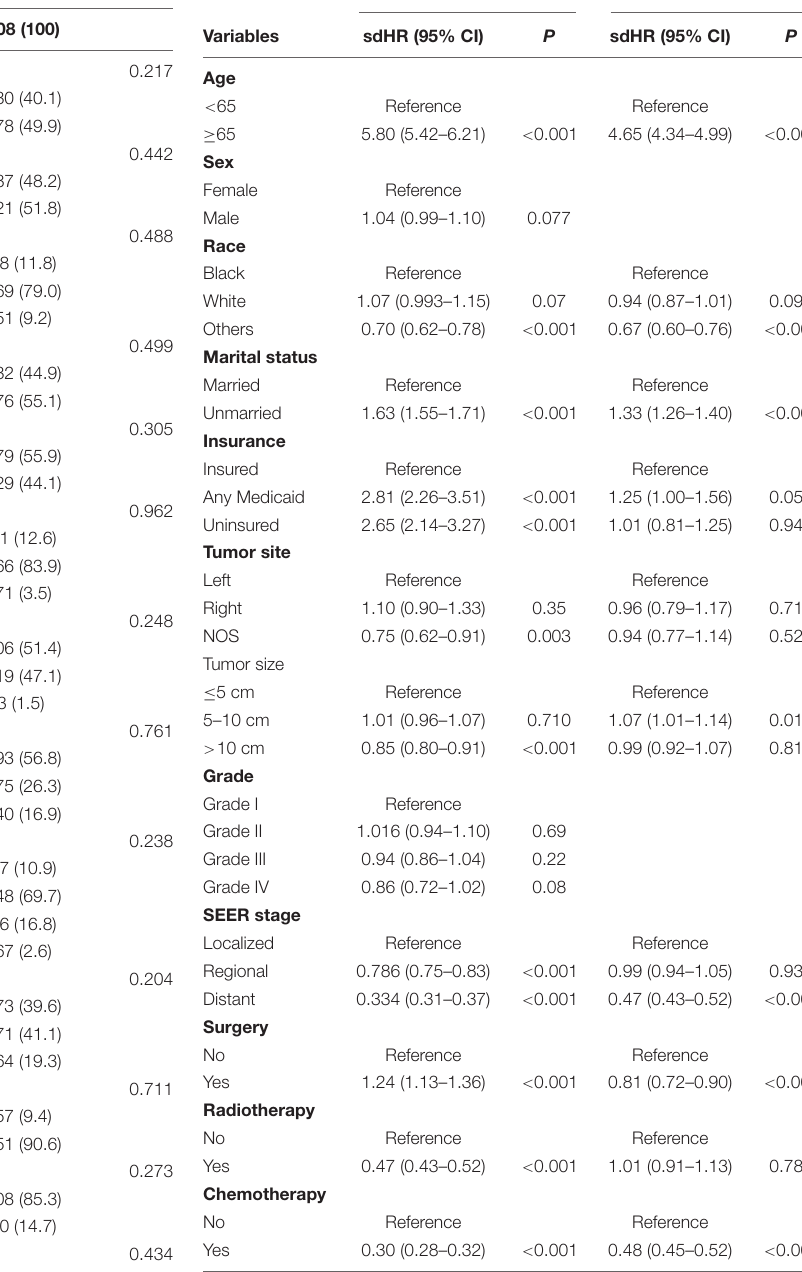
TABLE 4 | Univariate and multivariable competing risk analyses for cardiovascular death (CVD) among patients with colorectal cancer (CRC) in the training cohort. Univariate analysis Multivariate